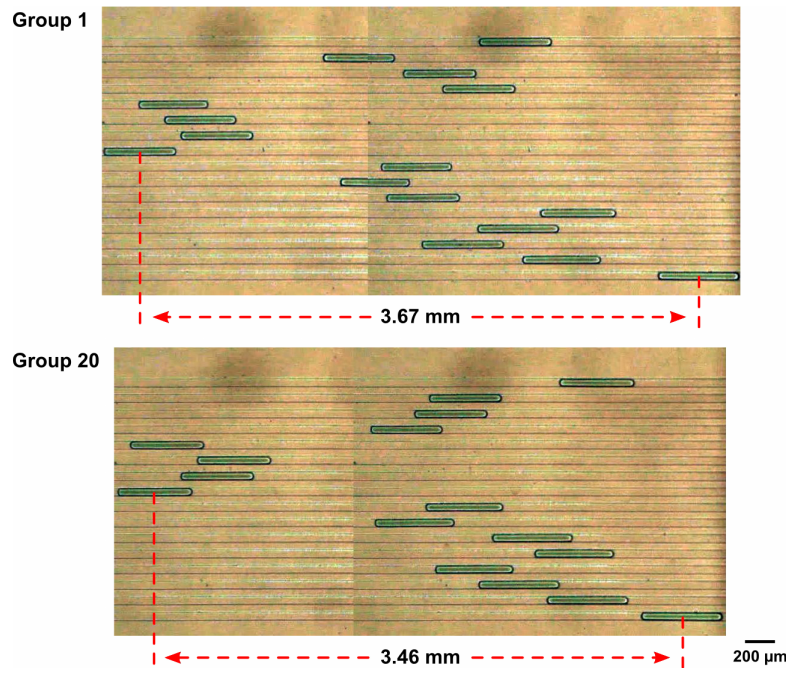
Figure 6. Imaging-Based Parallel Detection of Fused Droplets. We generate multiple groups of 16 droplets (four replicates of the four sample-reagent combination) and image them at the detection zone via microscopy. Even droplet bifurcation, uniform reagent injection, and robust droplet fusion enable size uniformity for the 16 droplets. For example, the droplet sizes in Group 1 and Group 20 have only a coefficient of variation of 8.0% and 6.6%, respectively. Furthermore, the droplets travel at relatively the same speed through their own incubation channels and thus allow their spatial indices to be maintained. Indeed, for the droplets in Group 1, the 16 droplets vary by only as much as 3.67 mm in position after traveling through the 100-mm-long incubation channels, equivalent to a 3.67% variation. For the droplets in Group 20, the 16 droplets mostly maintain their positional orders while the maximum difference in position is only 3.46 mm.